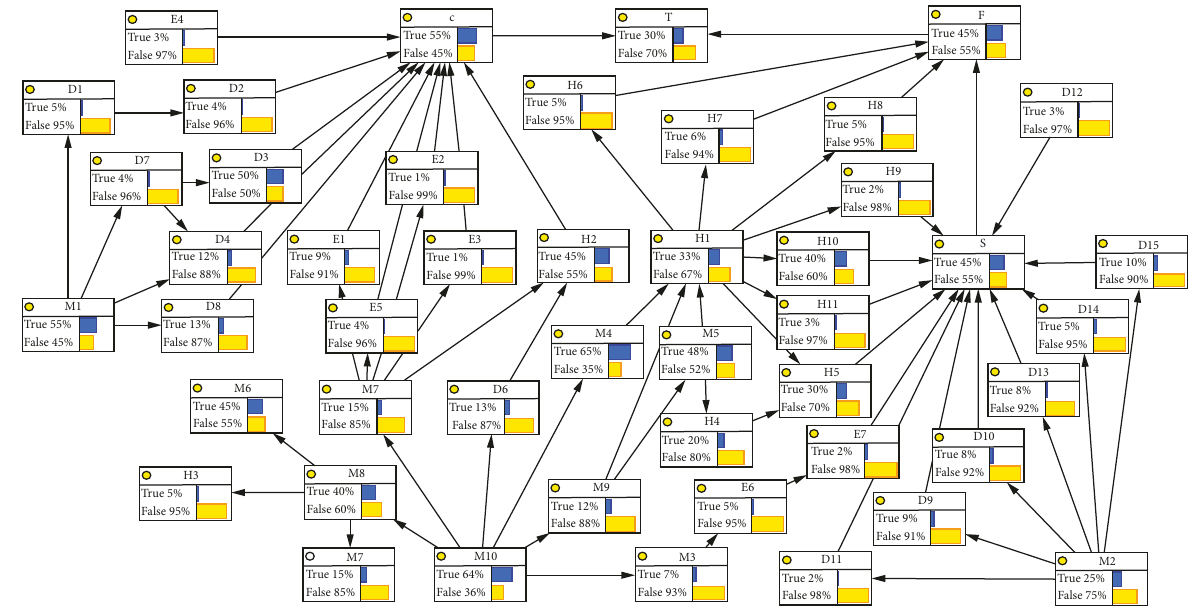
Figure 4: Conditional probability distribution graph of Bayesian network.